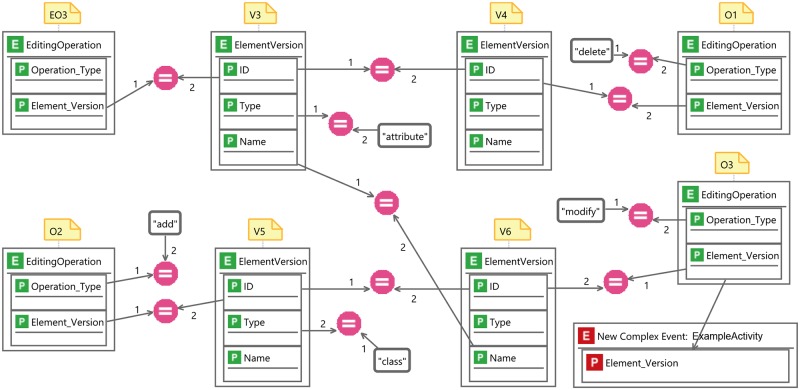
Example activity modeled in MEdit4CEP [24].